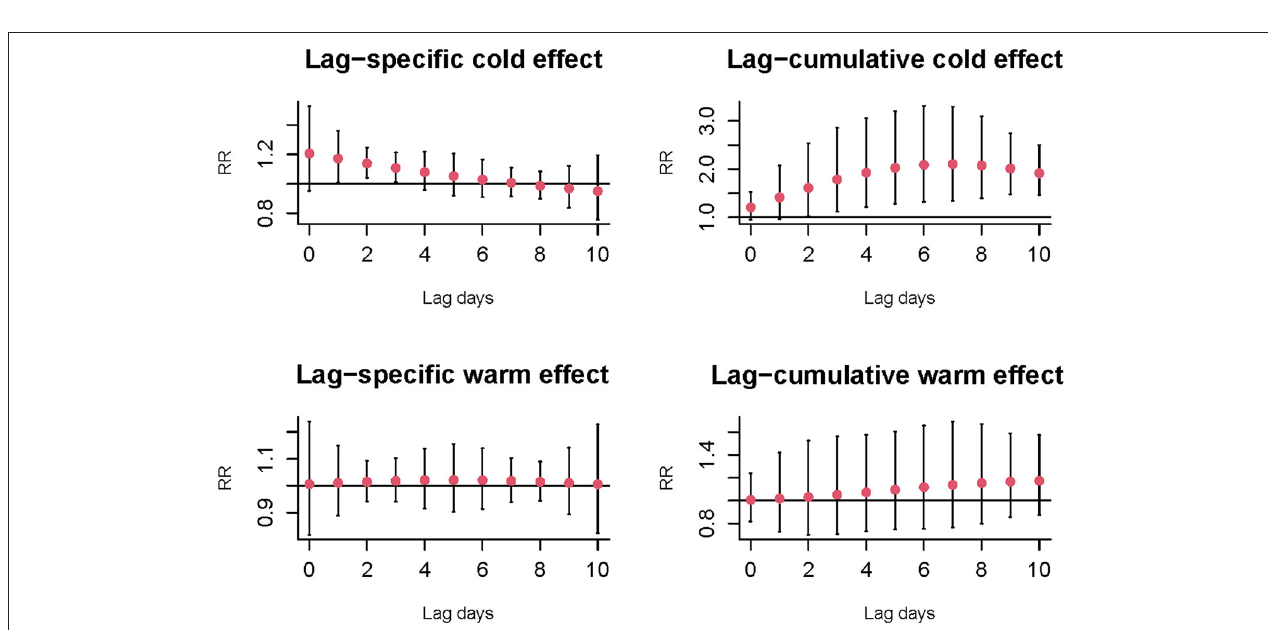
FIGURE 1 | The relative risks and 95%CI of cold ( − 2.0 vs. 25.8 ◦ C) and warm effect (37.0 vs. 25.8 ◦ C) on the number of hospitalizations for osteoporotic fractures at single and cumulative lag days.